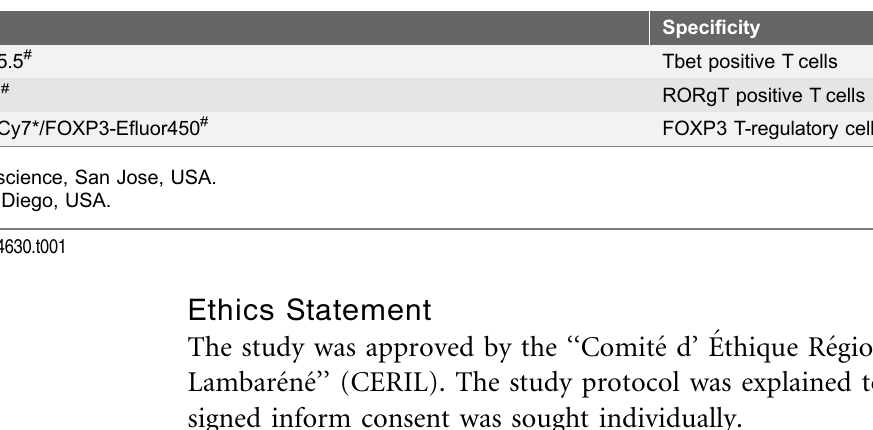
Table 1. Combinations of monoclonal antibodies used for the flow cytometry analysis.